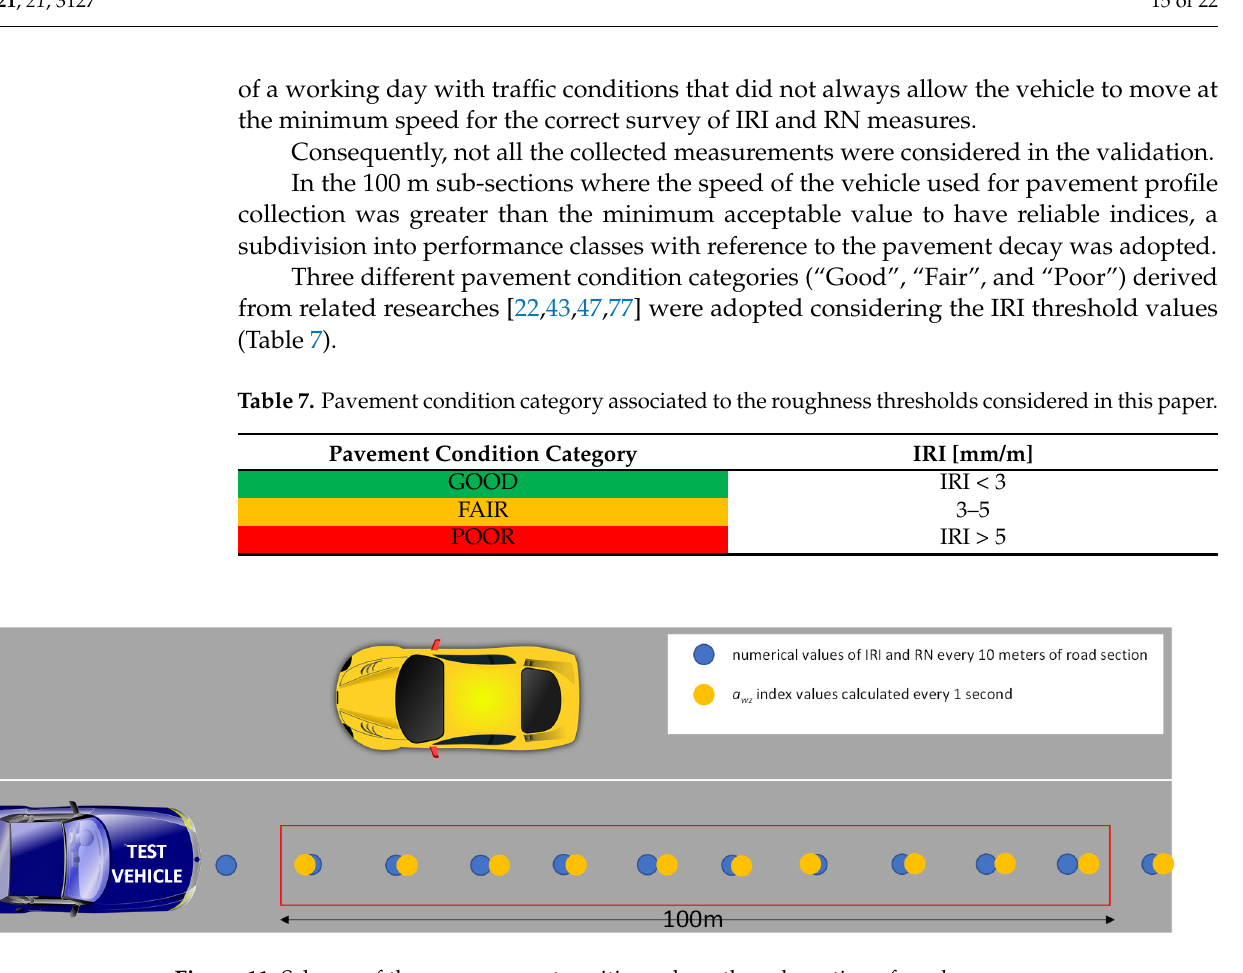
Figure 10. Comparison between speed values collected by LandMark 10 GPSA-150-10-200 and SENSOR#1 at the same time sample.